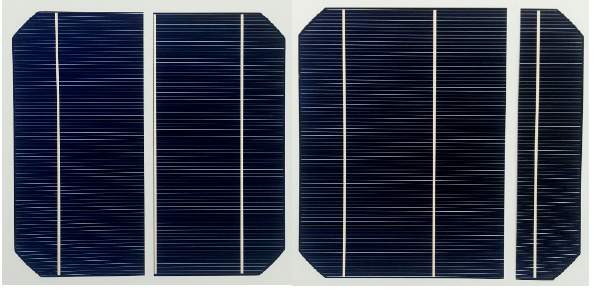
Figure 14. Cut c-Si solar cell.